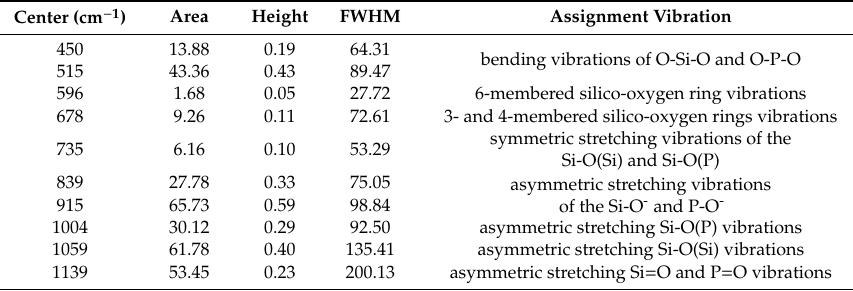
Table 4. Parameters of the component bands of the MIR spectrum of the 45S5_0h sample [35–44]. Center (cm − 1 )